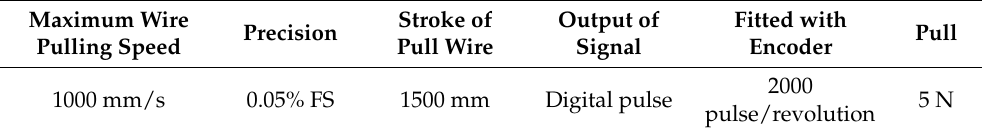
Table 2. Pull-wire sensor parameters.